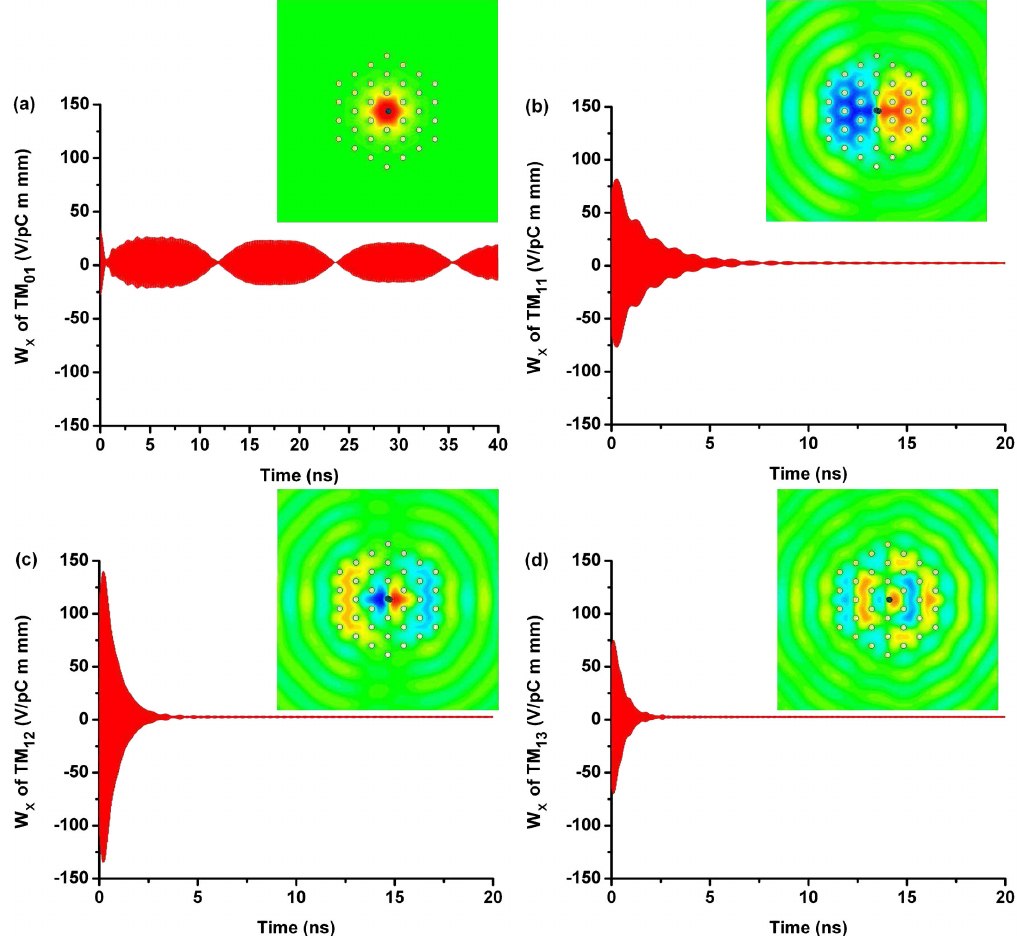
FIG. 4. Transverse wake potential as a function of time for each mode in the PBG structure: (a) TM 01 -like mode at 17.1 GHz; (b) TM 11 -like mode at 23.0 GHz; (c) TM 12 -like mode at 24.8 GHz; (d) TM 13 -like mode at 27.5